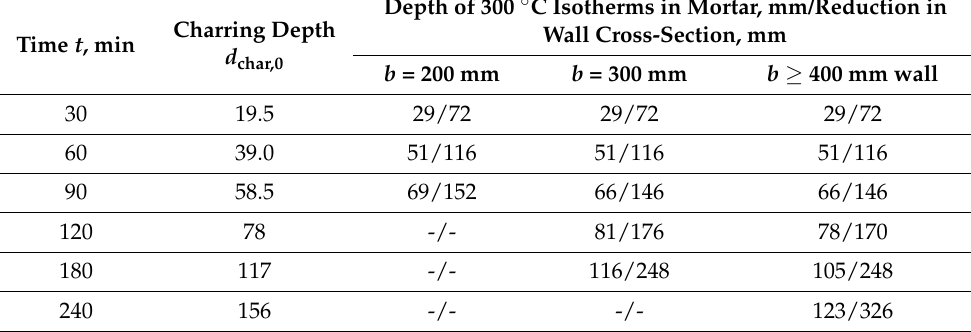
Table 2. Depth of 300 ◦ C isotherms for timber and mortar wall in case of double-sided fire for walls with thicknesses b equal to 200 mm, 300 mm and 400 mm and